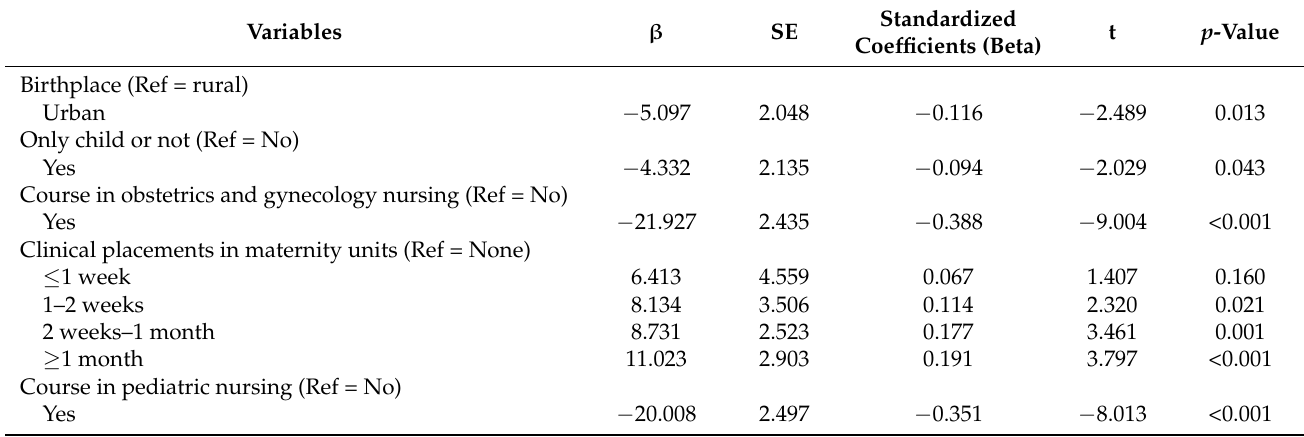
Table 4. Multivariate analysis of breastfeeding knowledge scores of nursing undergraduates ( n =